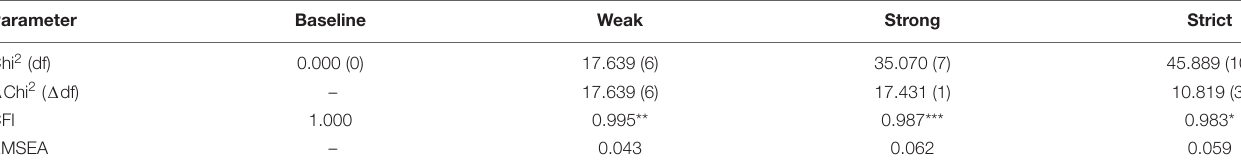
TABLE 5 | Fit indices for measurement invariance models for men and women: baseline (unconstrained), weak (measurement weights), strong (measurement intercept), and strict (measurement residual) ( N = 1039). Parameter